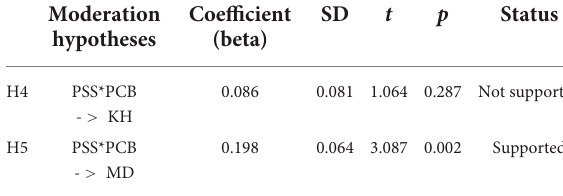
TABLE 9 Hypotheses testing